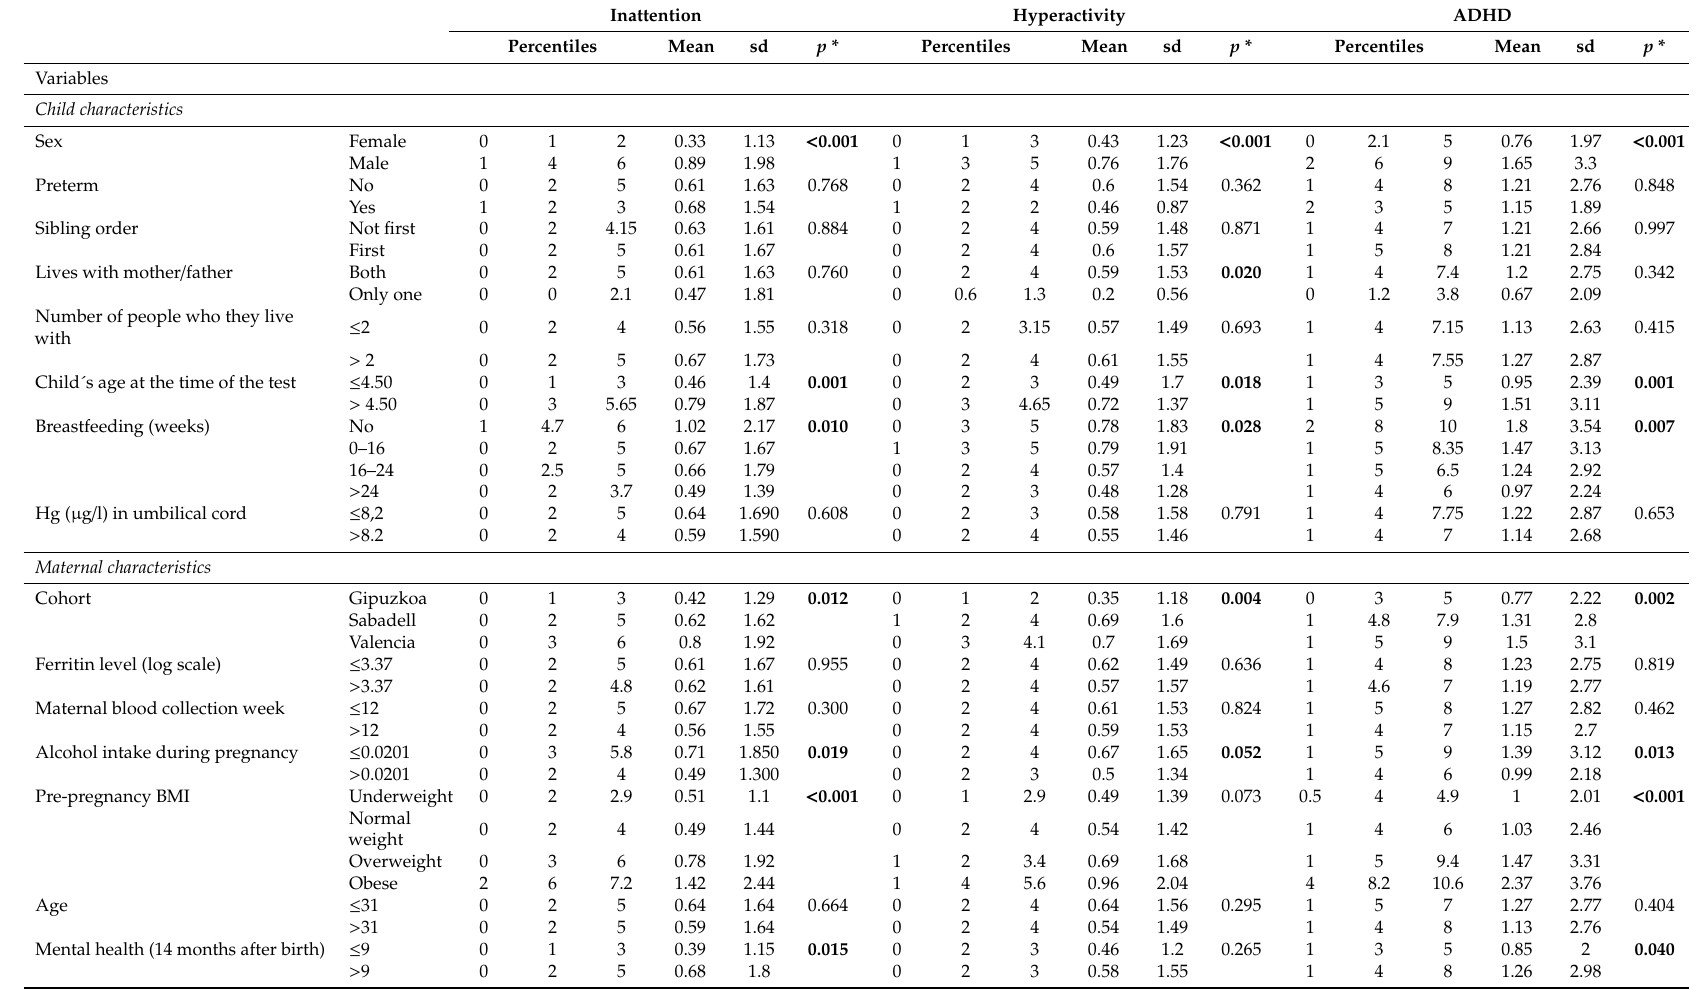
Table 2. Percentiles 75–90–95, mean and standard deviation for inattention, hyperactivity and ADHD